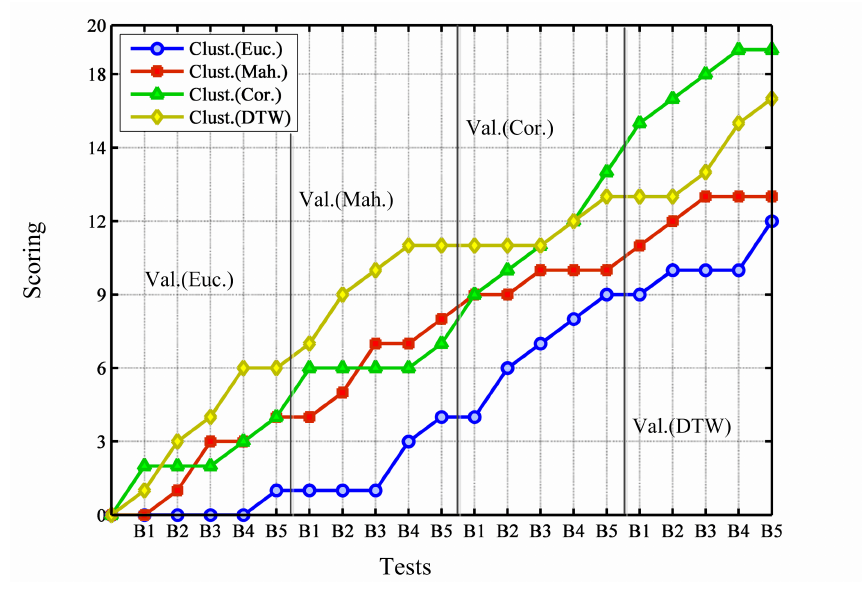
Figure 6. Comparison of the capability to discover the best individual clusters